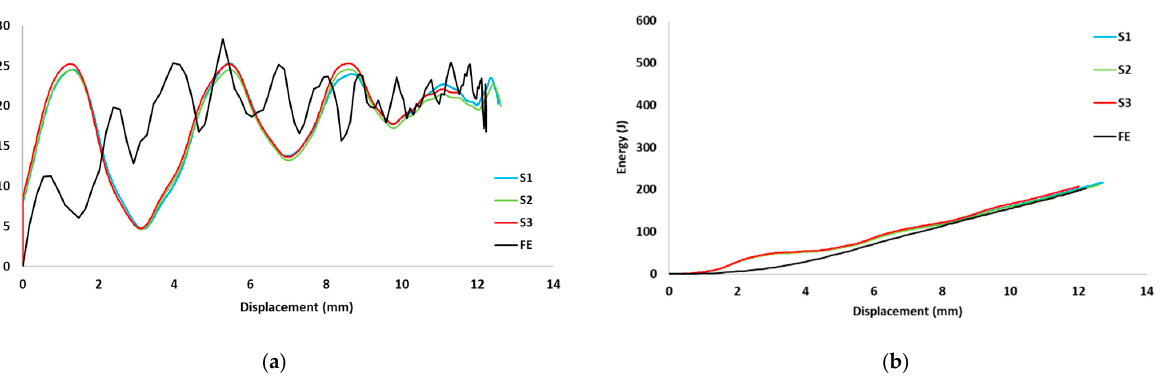
Figure 9. ( a ) Experimental and predicted load vs. displacement curves, ( b ) Energy vs. displacement for hat-shaped crush at crush speed of 2.13 m/s.